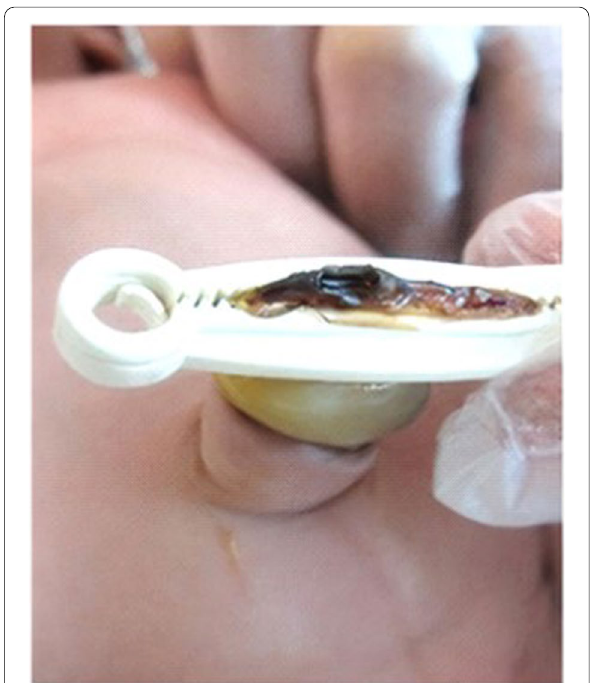
Fig. 5 Case presenting with bowel obstruction due to clamping on small loop of bowel by an umbilical clamp needed exploration and end to end anastomosis of the cut